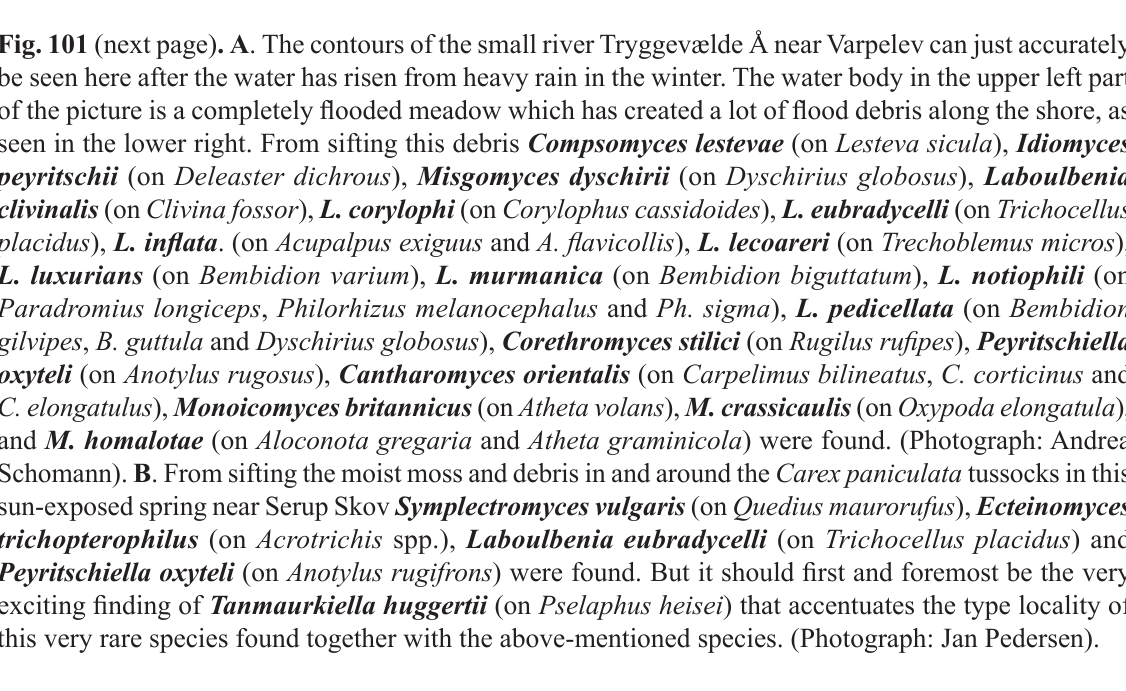
Fig. 101 (next page) . A . The contours of the small river Tryggevælde Å near Varpelev can just accurately be seen here after the water has risen from heavy rain in the winter. The water body in the upper left part of the picture is a completely flooded meadow which has created a lot of flood debris along the shore, as seen in the lower right. From sifting this debris Compsomyces lestevae (on Lesteva sicula ), Idiomyces peyritschii (on Deleaster dichrous ), Misgomyces dyschirii (on Dyschirius globosus ), Laboulbenia clivinalis (on Clivina fossor ), L. corylophi (on Corylophus cassidoides ), L. eubradycelli (on Trichocellus placidus ), L. inflata . (on Acupalpus exiguus and A. flavicollis ), L. lecoareri (on Trechoblemus micros ), L. luxurians (on Bembidion varium ), L. murmanica (on Bembidion biguttatum ), L. notiophili (on Paradromius longiceps , Philorhizus melanocephalus and Ph. sigma ), L. pedicellata (on Bembidion gilvipes , B. guttula and Dyschirius globosus ), Corethromyces stilici (on Rugilus rufipes ), Peyritschiella oxyteli (on Anotylus rugosus ), Cantharomyces orientalis (on Carpelimus bilineatus , C. corticinus and C. elongatulus ), Monoicomyces britannicus (on Atheta volans ), M. crassicaulis (on Oxypoda elongatula ), and M. homalotae (on Aloconota gregaria and Atheta graminicola ) were found. (Photograph: Andrea Schomann). B . From sifting the moist moss and debris in and around the Carex paniculata tussocks in this sun-exposed spring near Serup Skov Symplectromyces vulgaris (on Quedius maurorufus ), Ecteinomyces trichopterophilus (on Acrotrichis spp.), Laboulbenia eubradycelli (on Trichocellus placidus ) and Peyritschiella oxyteli (on Anotylus rugifrons ) were found. But it should first and foremost be the very exciting finding of Tanmaurkiella huggertii (on Pselaphus heisei ) that accentuates the type locality of this very rare species found together with the above-mentioned species. (Photograph: Jan